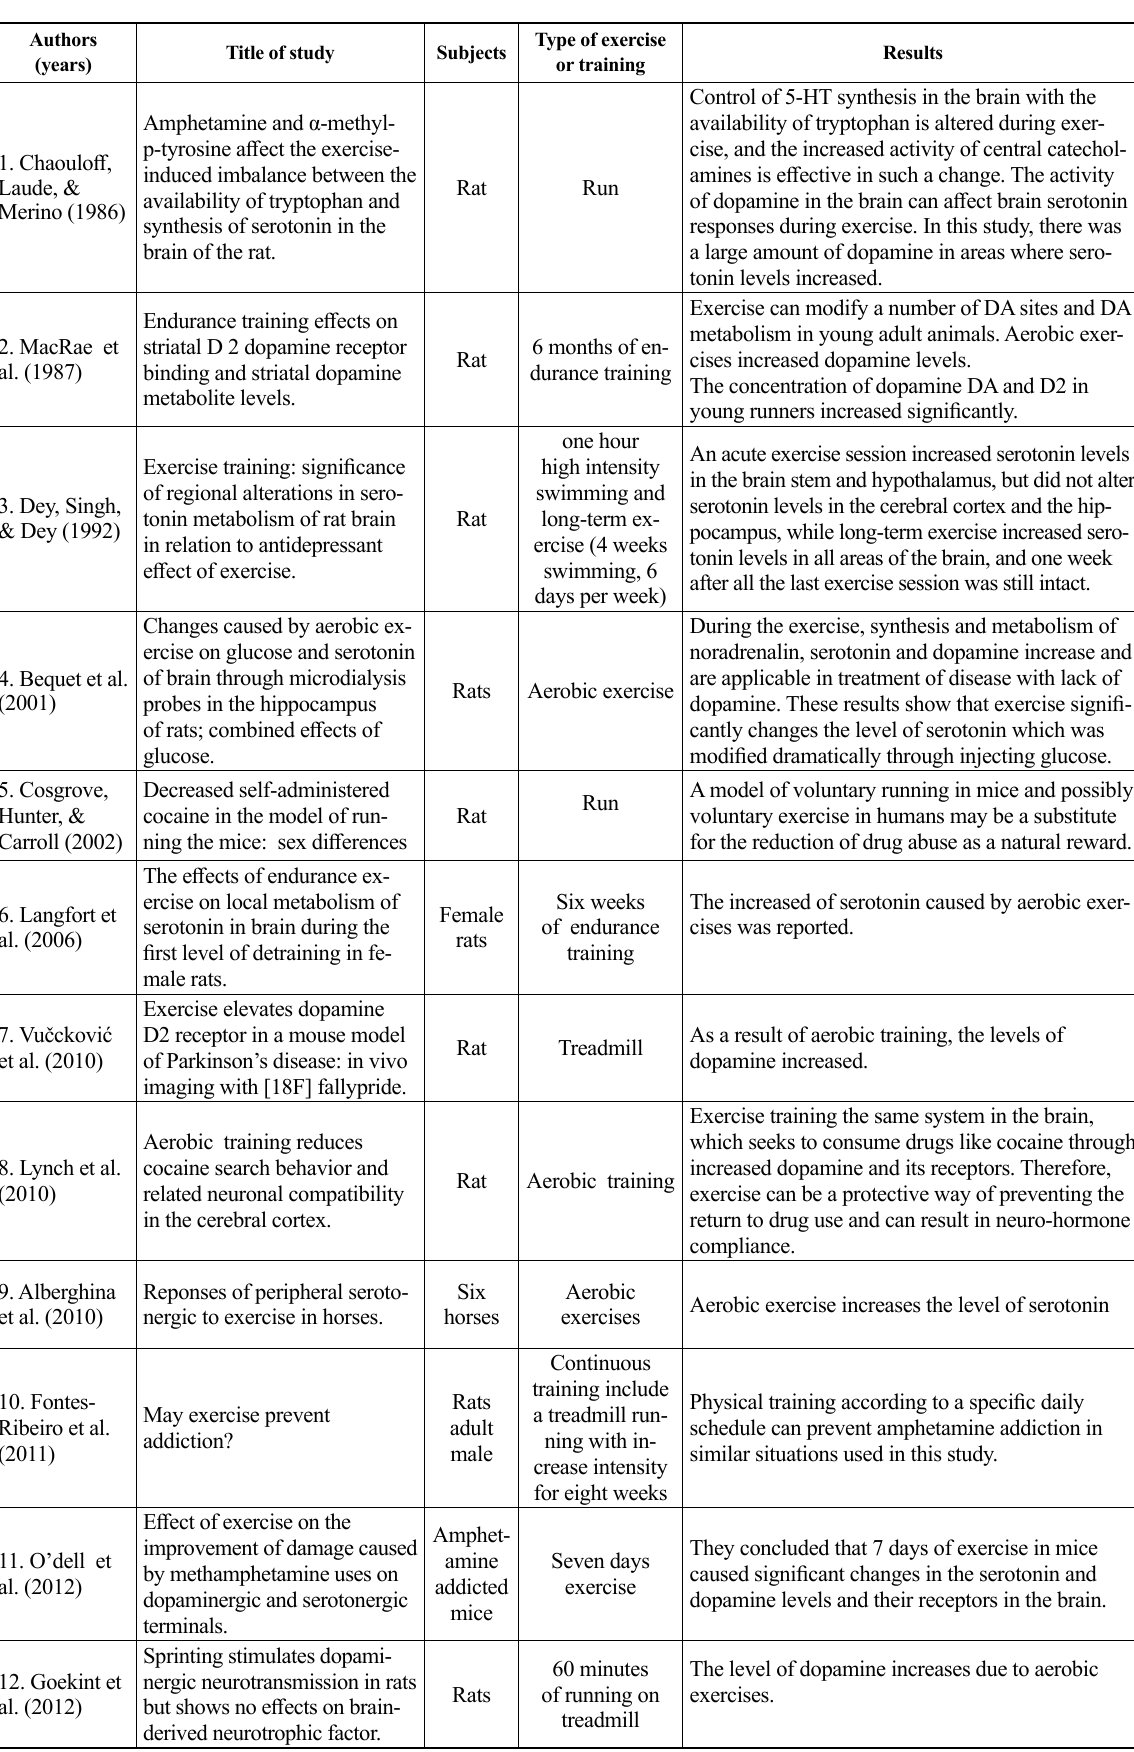
Table 1. Summary of animal studies on the effects of various training on neurotransmitter and addiction related